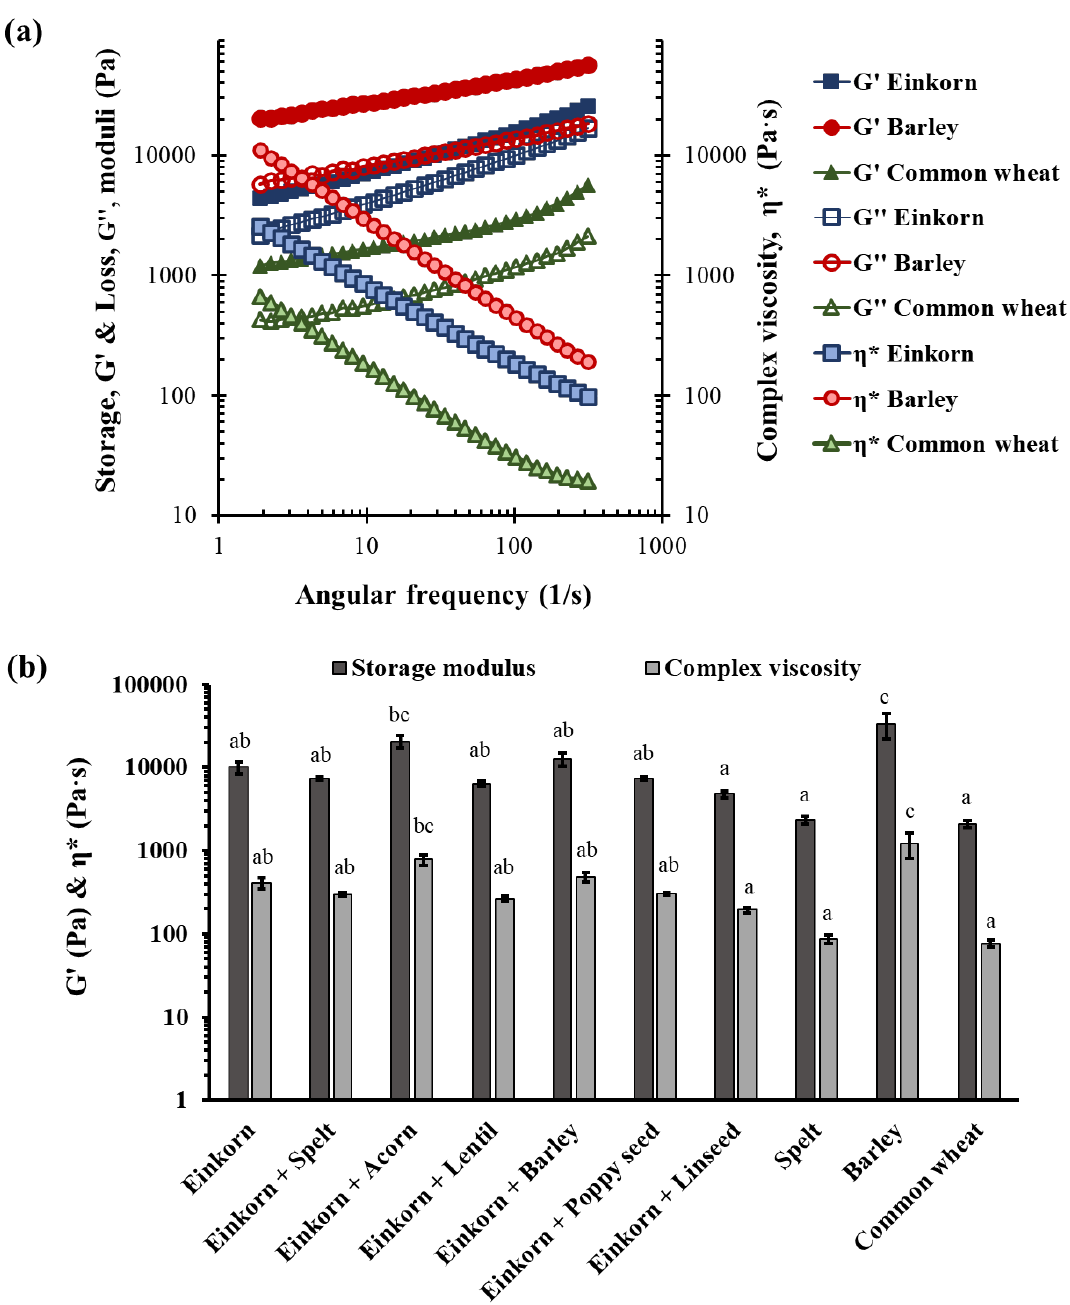
Figure 5. Representative mechanical spectra of doughs (flour:water 50:50 w / w ) of the flour samples used for breadmaking ( a ) and the derived storage modulus, G′, and complex viscosity, η*, at 30 1/s angular frequency ( b ); strain 0.01%, 20 °C. Values followed by the same letter for the each specified rheological parameter are not significantly different ( p > 0.05, Tukey’s test); notation of samples as in Table 1.